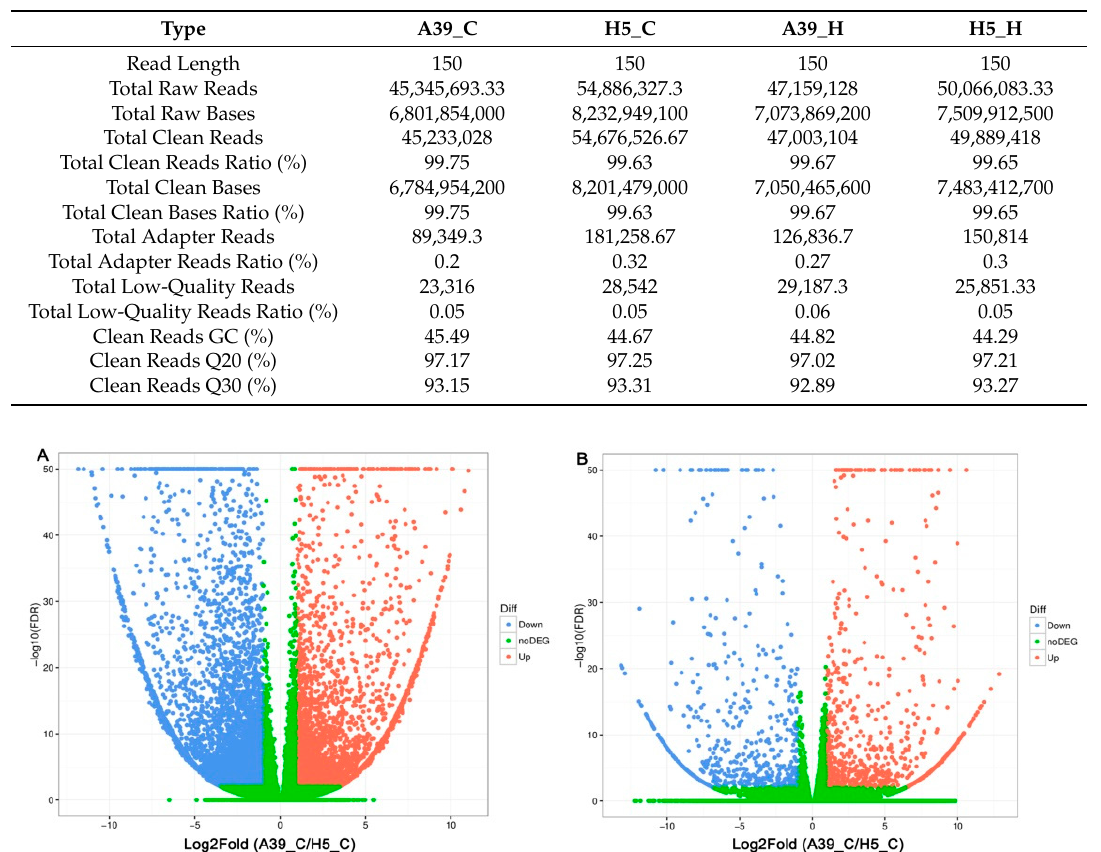
Table 1. Sample filtering statistics of A39 and H5